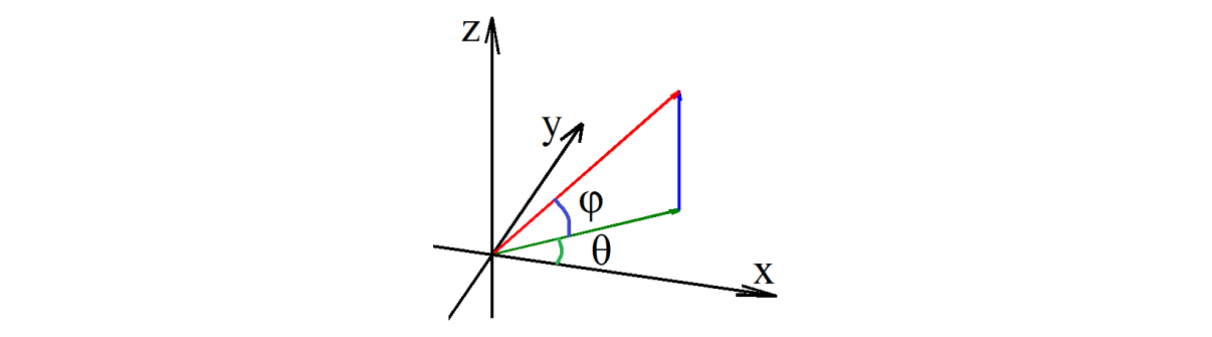
Figure 1. Two angles related to gradient direction calculation in 3D space.